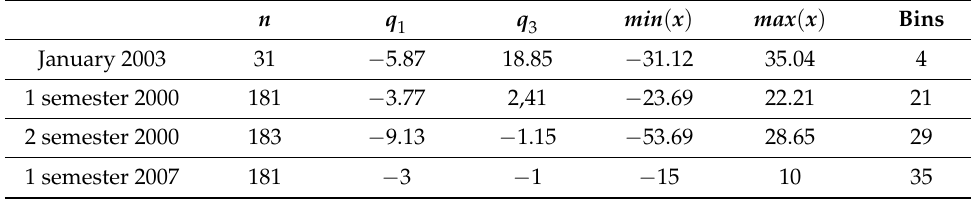
Table 1. RDMN statistical parameters related to Freedman – Diaconis rule.